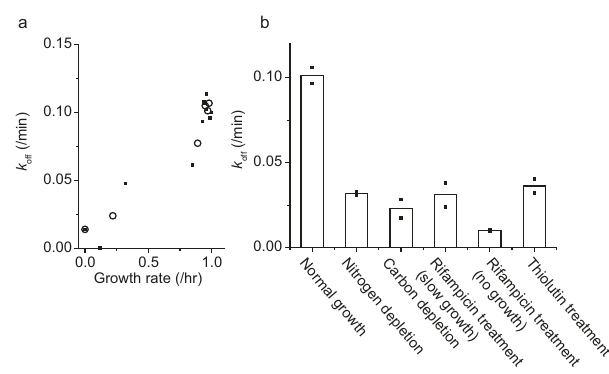
Fig. 2 Cell growth affects HCT unbinding. a Data from Fig. 1b and d were put together to fi nd the relationship between k off and λ . b k off under various conditions. Rifampicin and thiolutin were used to repress transcription. The results show an important effect of transcription on k off . See Supplementary Fig. 5 for k off under translation repression by chloramphenicol. See Supplementary Videos 4 and 5 for time-lapse images of HCT intensity under rifampicin treatment and chloramphenicol treatments, respectively. Small solid symbols indicate the data from two biological repeats, and the open symbols and columns indicate their